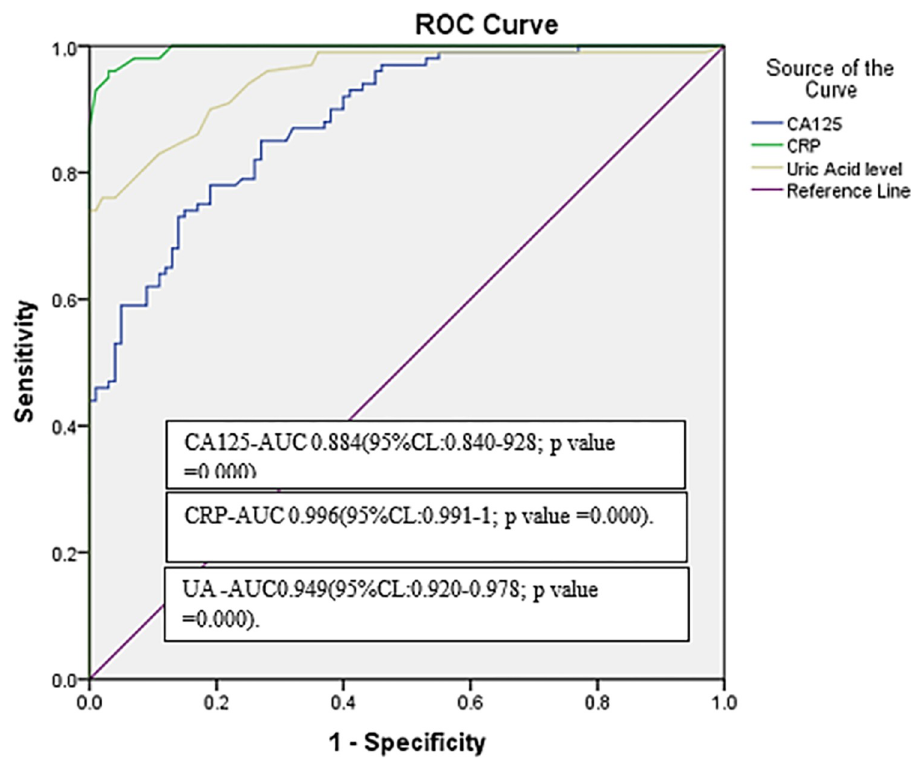
Fig 4. Receiver operating characteristic (ROC) curve of serum cancer antigen-125 (CA-125), C-reactive protein (CRP) and uric acid (UA) levels in preeclampsia.